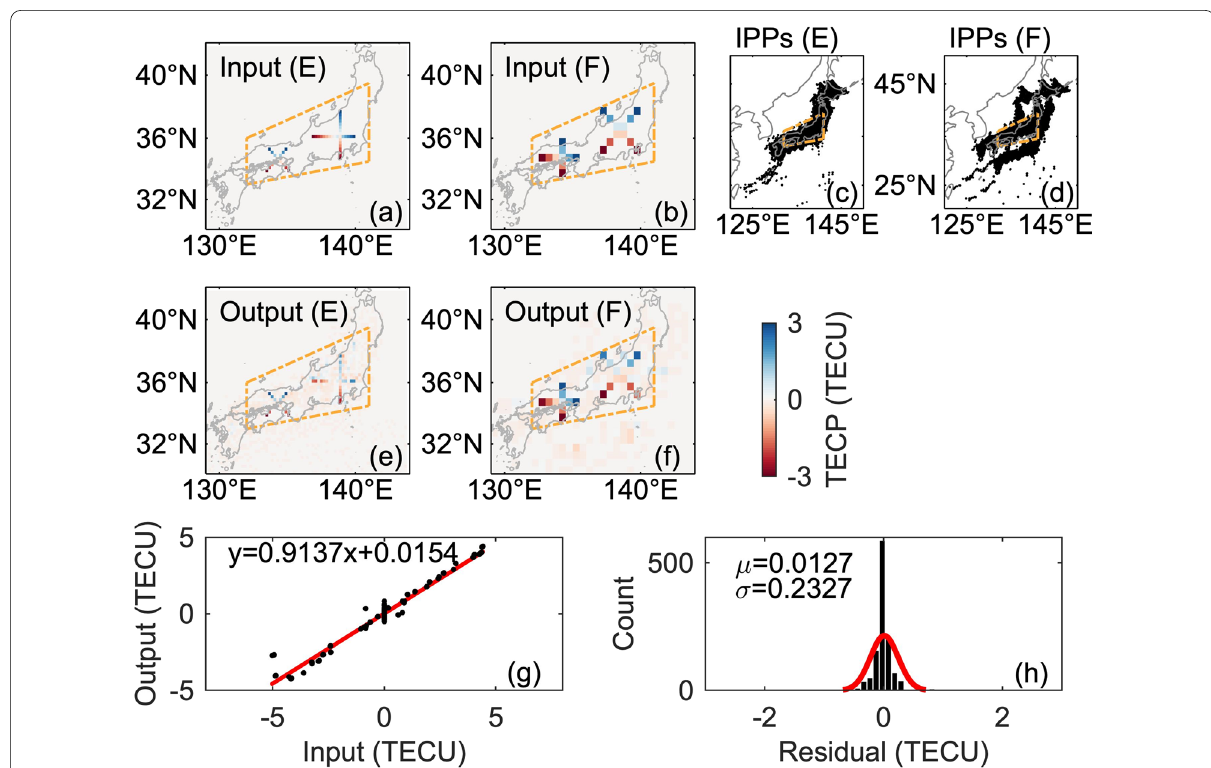
Fig. 4 2-D maps of input ( a , b ), IPP distribution ( c , d ), output ( e , f ) irregularities at E- and F-shell heights, a scatter of input and output total electron content perturbation (TECP) values ( g ) and a distribution of residuals ( h ) using GNSS signal rays at 17:30 JST, on 21 May 2010 (DOY 141). The yellow dashed line indicates a region, where reconstruction is of highest confidence